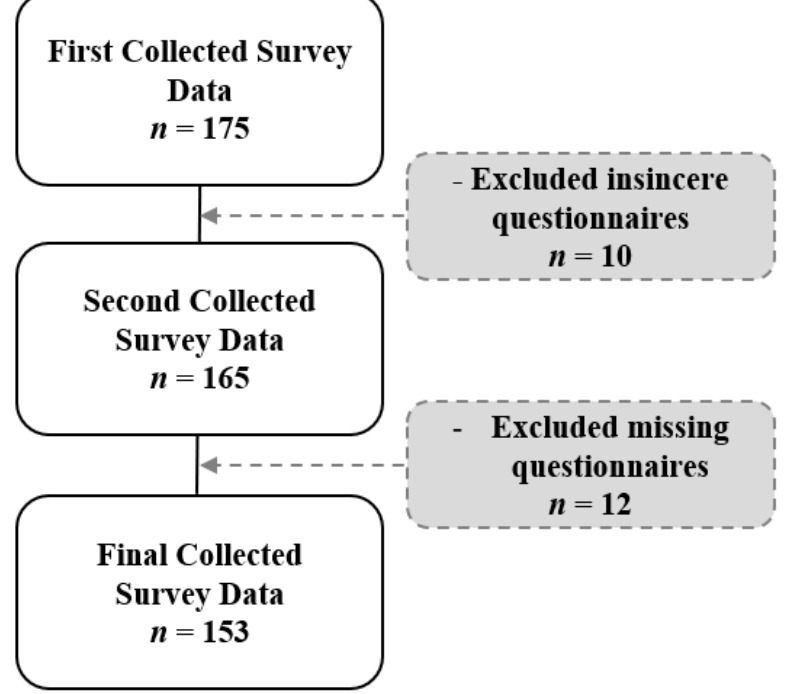
Figure 1. Flowchart of the study.